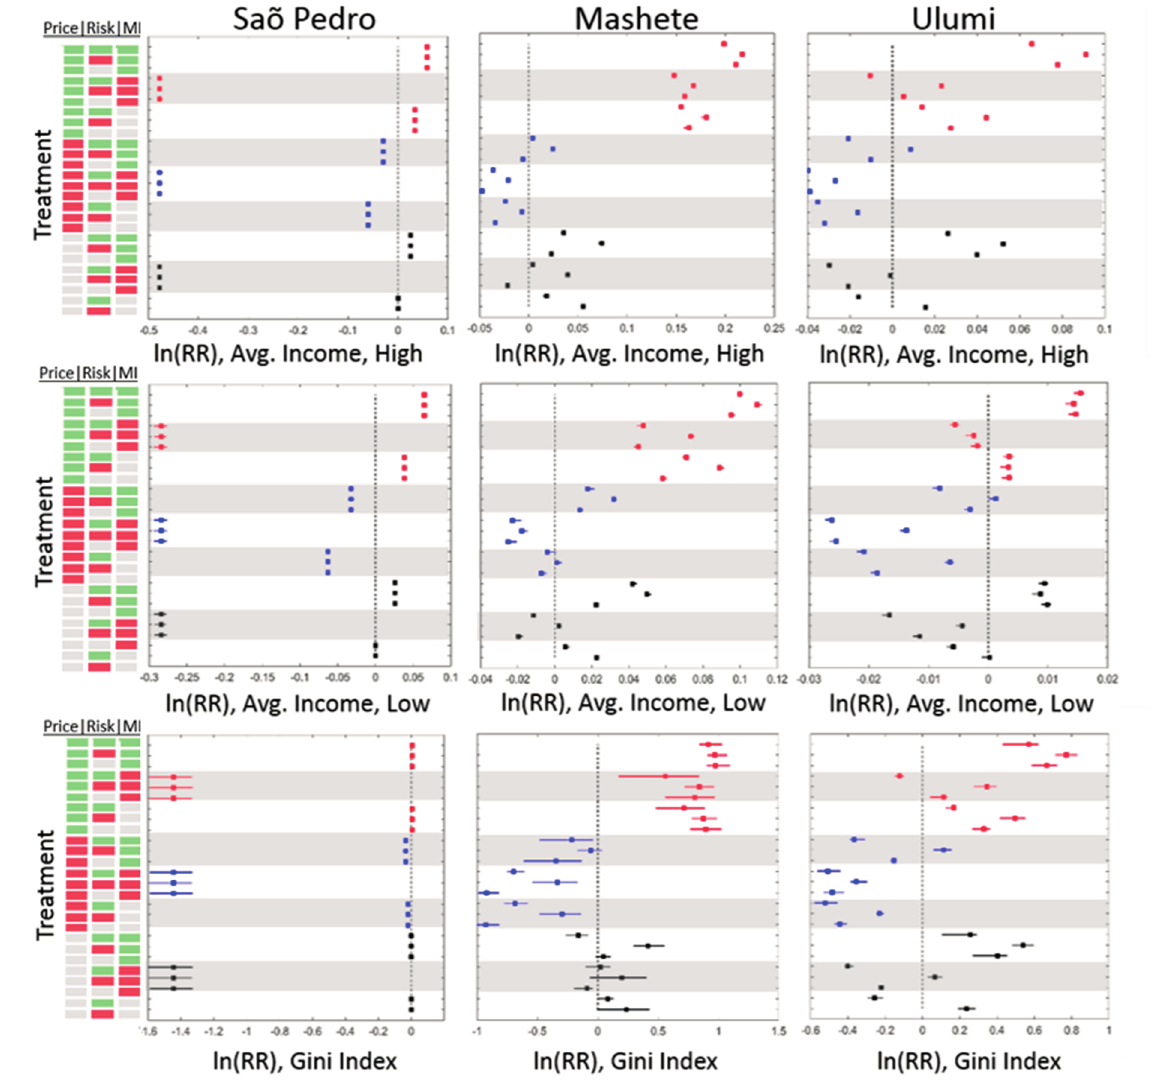
Figure 2. Mean effect sizes of experimental treatments for high ( top row) and low income ( middle row) household agents and income inequality measured by the Gini Index ( bottom row). Experimental treatments are indicated in the color-coded panels on the far left and are displayed as combinations of commodity price ( left column), average risk preference ( middle column), and market influence (MI, right column) perturbations. Green, gray, and red treatment cells indicate increased, baseline, and decreased treatment values, respectively. Effect sizes are plotted with the mean and 95% confidence interval. Interpretation . Effect sizes are significant at α =0.05 level when intervals do not include zero or do not overlap between categories [73,74]. Within each plot, effect sizes are grouped and colored by commodity price level (red points = higher prices; blue points = lower prices; black points = baseline prices). White and gray bands group experimental treatments by market influence settings. Thus, the relative influence of risk preferences is shown by the amount of horizontal dispersion of points within a white/gray